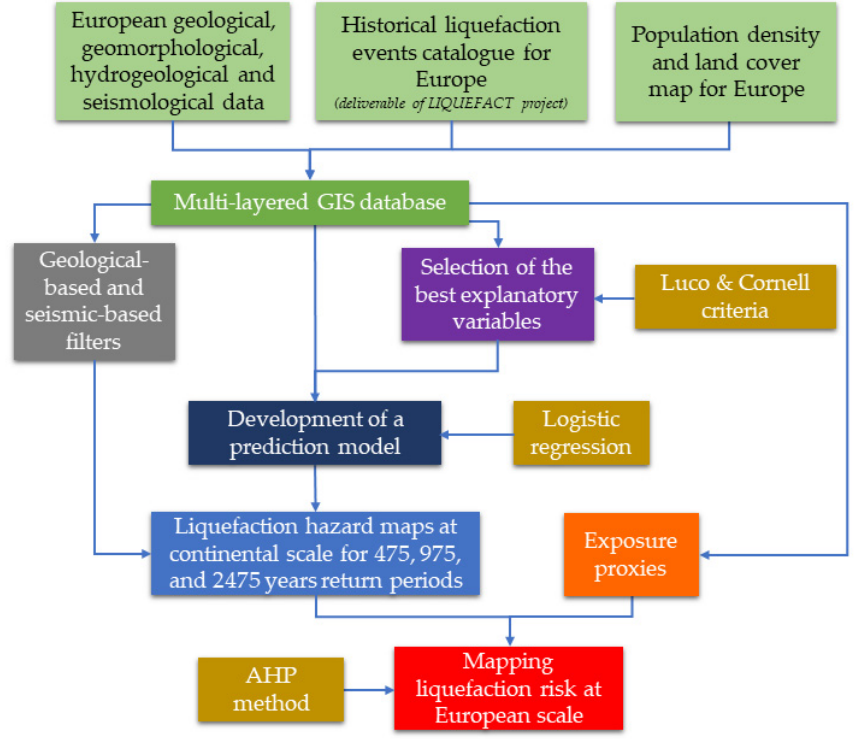
Figure 1. Flowchart of the geospatial approach developed in this study for mapping the liquefaction risk at a continental scale.